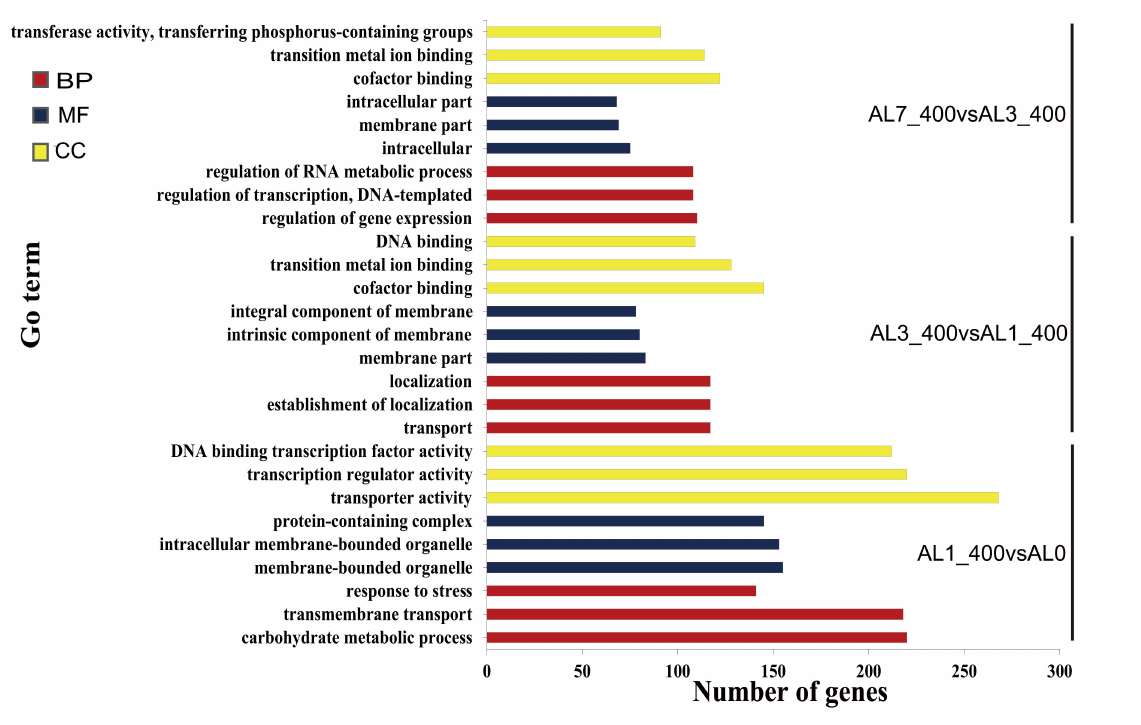
Figure 8. Di ff erential gene GO enrichment among di ff erent combinations of aluminum stress comparison. The abscissa is the GO term, the enrichment is the number of di ff erential genes in the term, and 27 GO terms with the most significant enrichment in di ff erent periods are selected to show in the map. The red bar column represents the DEGs which enriched on biological process; the blue bar column represents the DEGs which enriched on molecular function; the yellow bar column represents DEGs which enriched on cellular